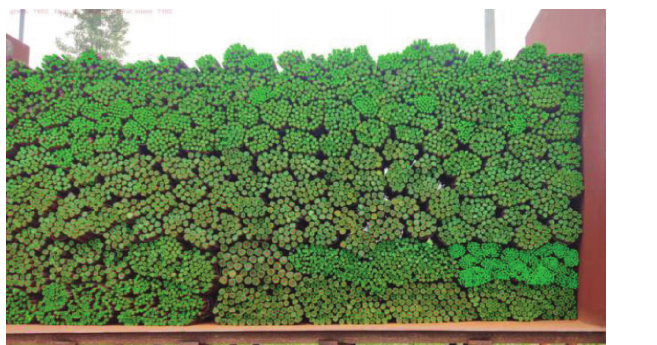
Fig 5. (Color online) recognition results on platform dataset.